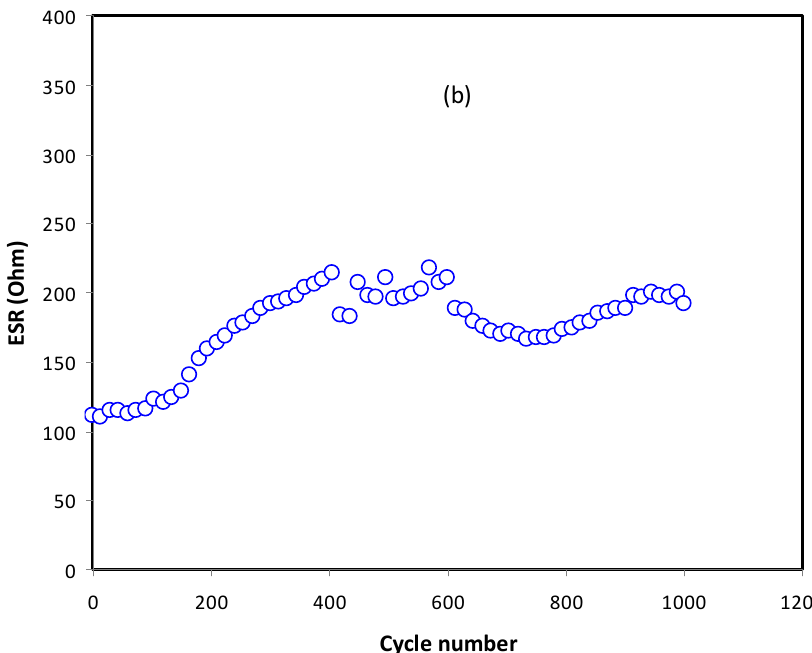
Figure 9. ( a ) Voltage drop pattern and ( b ) equivalent series resistance (ESR) pattern of the EDLC throughout the 1000 cycles.